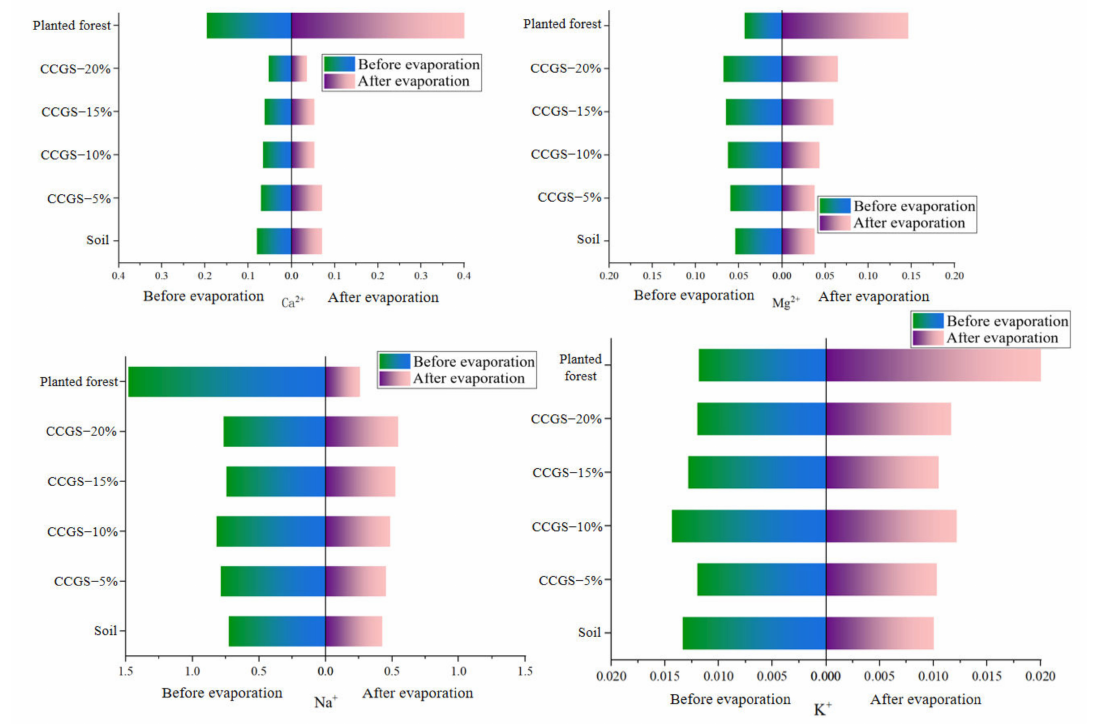
Figure 19. Changes of